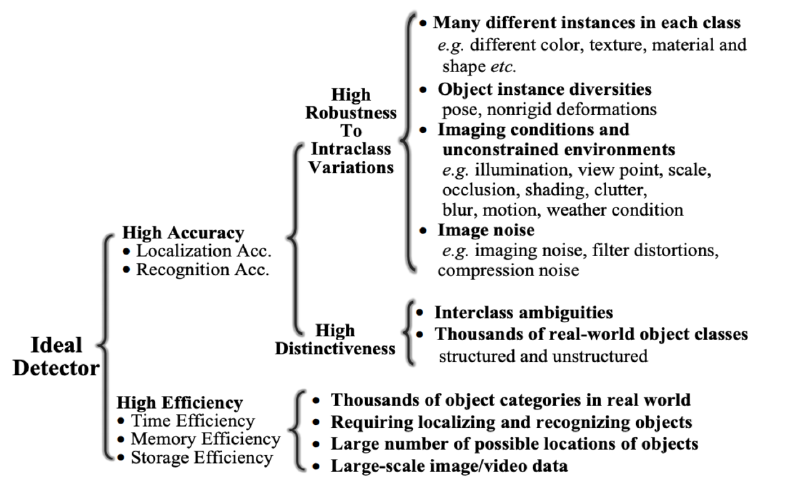
Figure 1. Challenges in generic object detection [9].